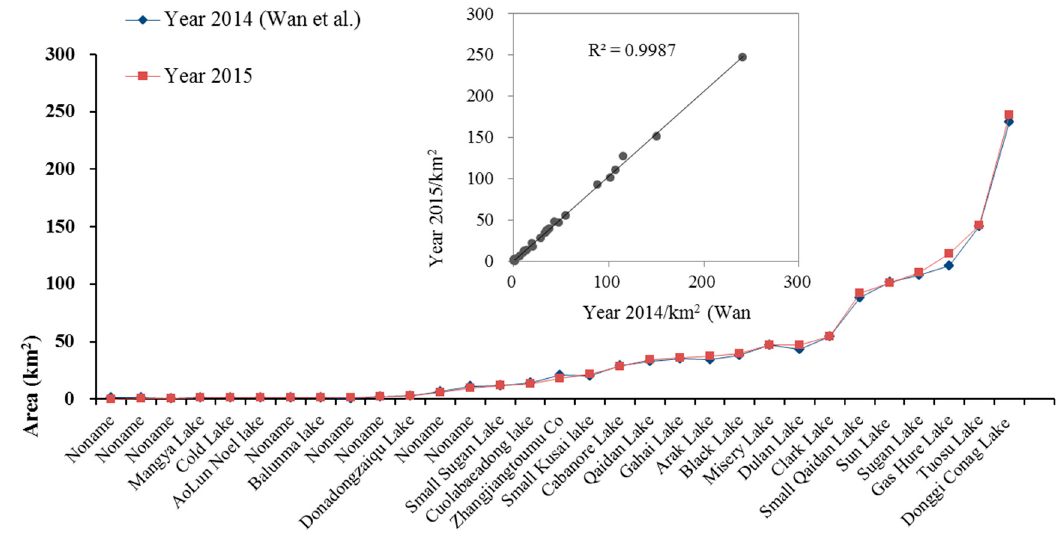
Figure 12. Comparison of the lake data set (2015) in this study and the data set of Wan’s (2014) [63] in the Qaidam Basin (QB).